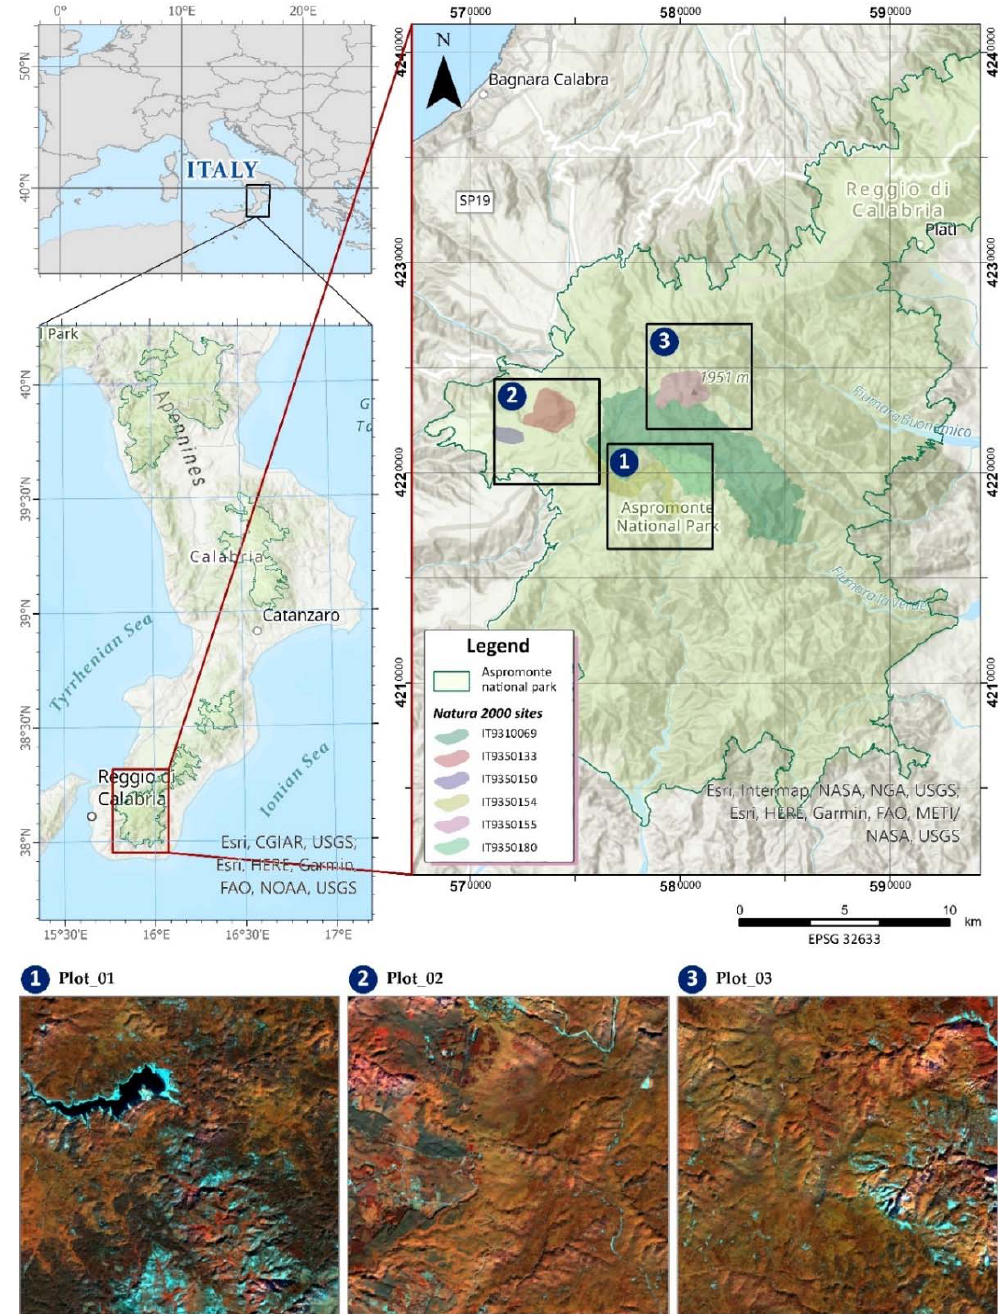
Figure 2. Geographical location of the study area— natural Aspromonte National Park—with the boundaries of the Natura 2000 sites considered. The three defined plots (Plot_01, Plot_02, and Plot_03) are shown as Sentinel-2 false colour images (RGB 7,3,2 band